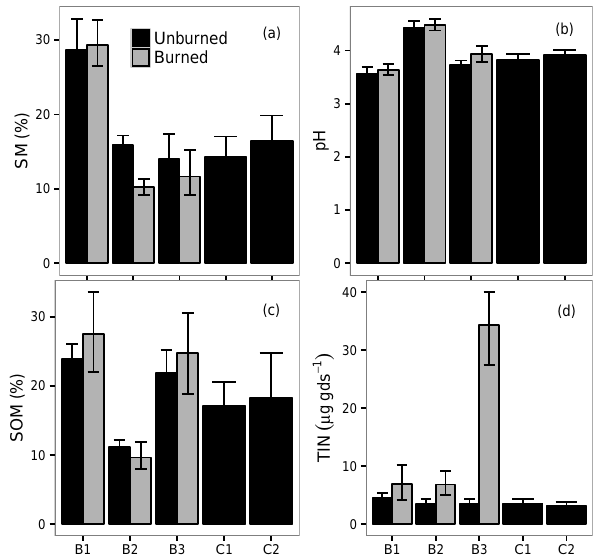
Figure 2. Mean soil moisture (SM; a ), pH (b) , soil organic matter (SOM; c ), and total inorganic N (TIN, i.e. NH + to and following burns at each site. TIN is reported per gram of dry soil (gds). Values are reported ± 95%CI.